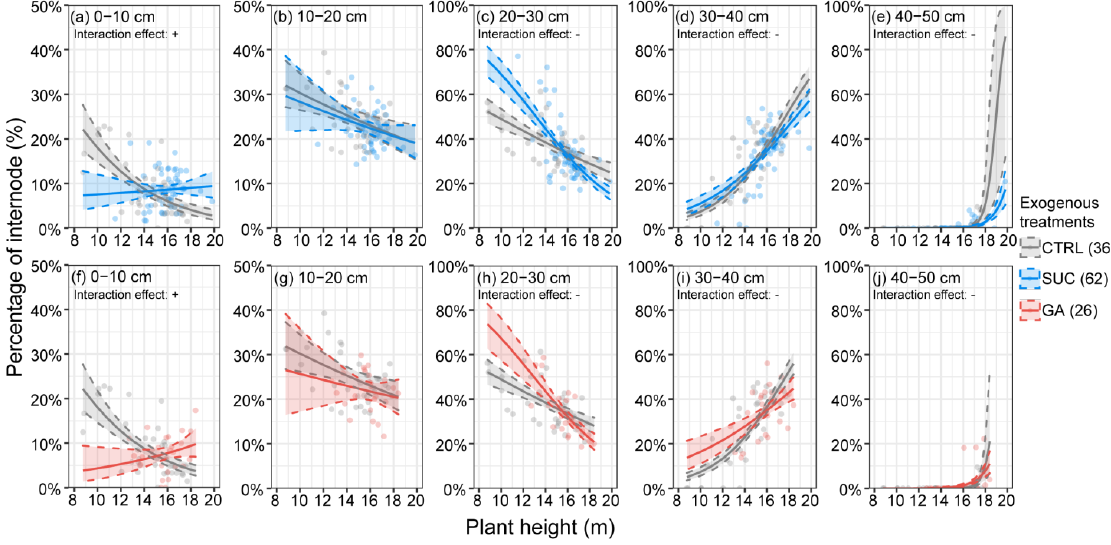
Figure 6. The effects of the interactions between the exogenous treatments and plant height on the percentage of internodes with different lengths (( a , f ) 0−10 cm, ( b , g ) 10−20 cm, ( c , h ) 20−30 cm, ( d , i ) 30−40 cm, and ( e , j ) 40−50 cm). The points represent the percentage of internodes of each length at different plant heights. The shaded intervals within the dashed line show the 95% Bayesian credible intervals. The numbers in brackets represent the sample sizes. The symbols + or − mean a significant positive or negative interaction, respectively.